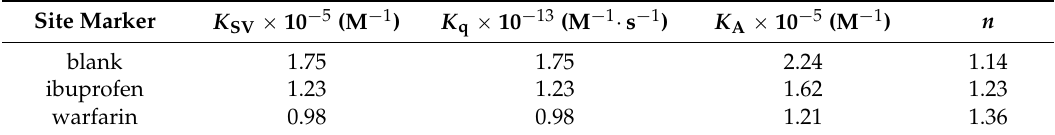
Table 1. Binding parameters of competitive experiments of 5,10,15-Tris(4-carboxyphenyl) corrole- Binding parameters of competitive experiments of